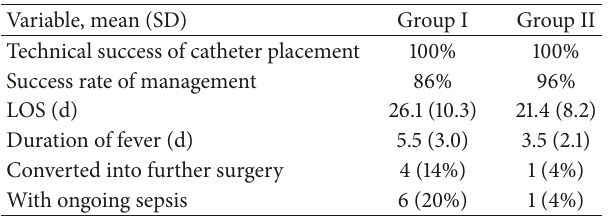
Table 3: Comparison of hospitalization and outcome variables among treatment